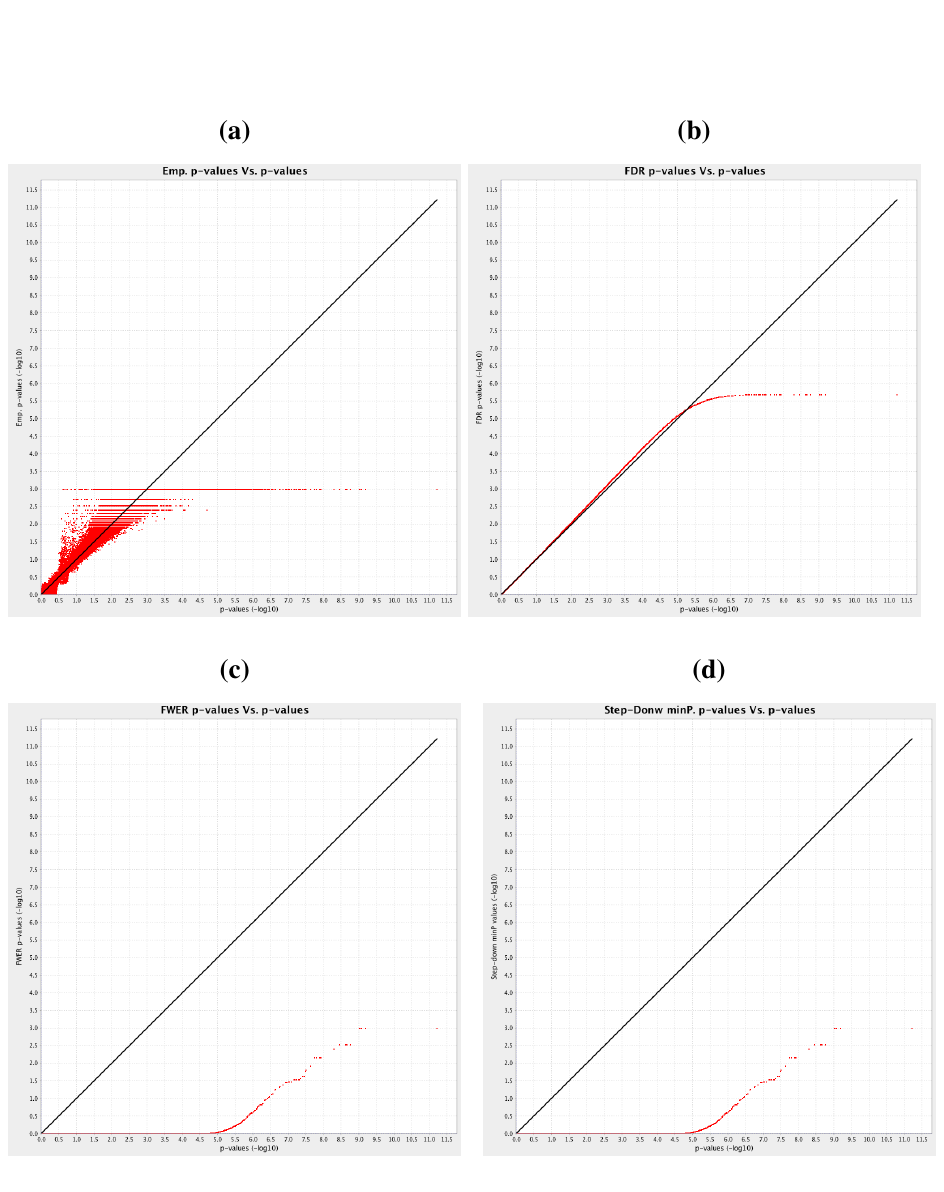
Figure 1: Original p-values plotted against a) empirical p-values, b) FDR-corrected p-values, c) FWER-corrected p-values, and d) Step-down minP corrected p-values, from the PCOS dataset using 1000 permutations. Apparently, Bonferoni corretion is too strict. We suggest to use FDR correction or empirical